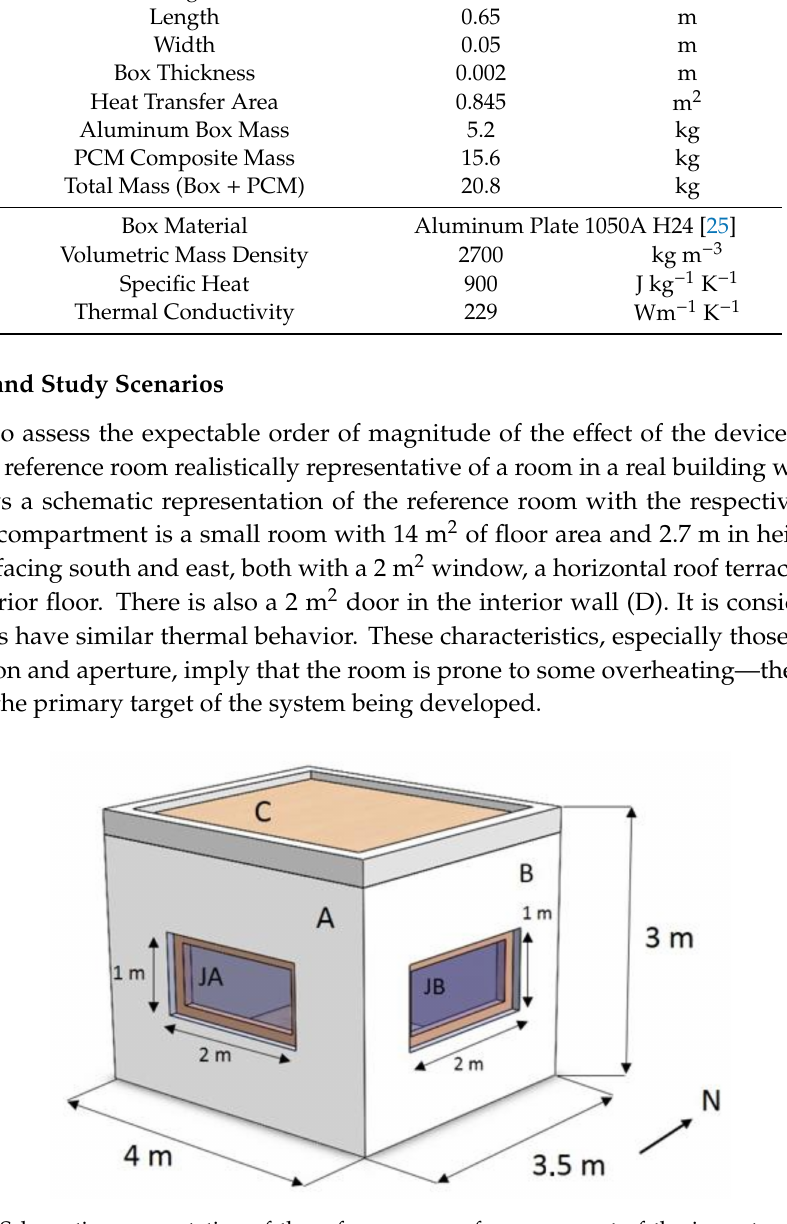
Figure 3. Schematic representation of the reference room for assessment of the impact upon indoor